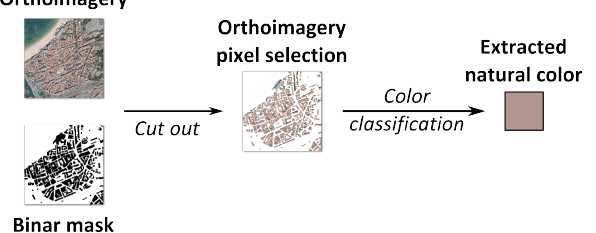
Figure 2: Buildings’ natural color extraction